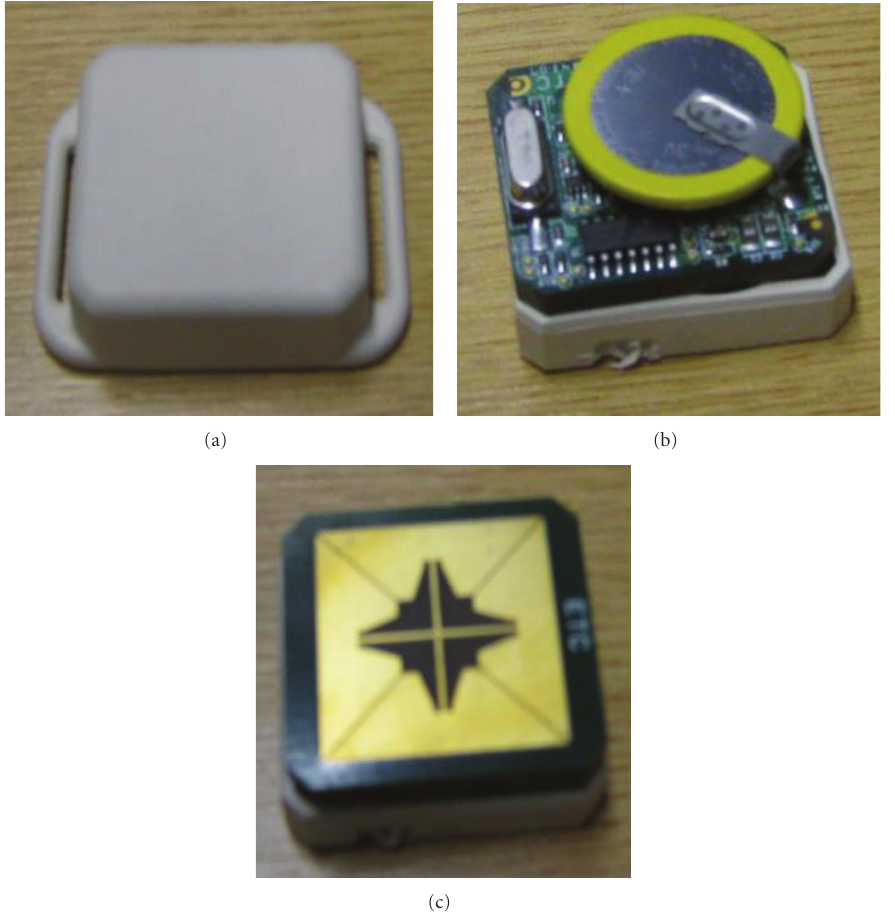
Figure 2: (a) UWB active transmitter tag encased inside the plastic housing, (b) tag without plastic housing and bottom view, and (c) top view of the tag showing the transmitter tag